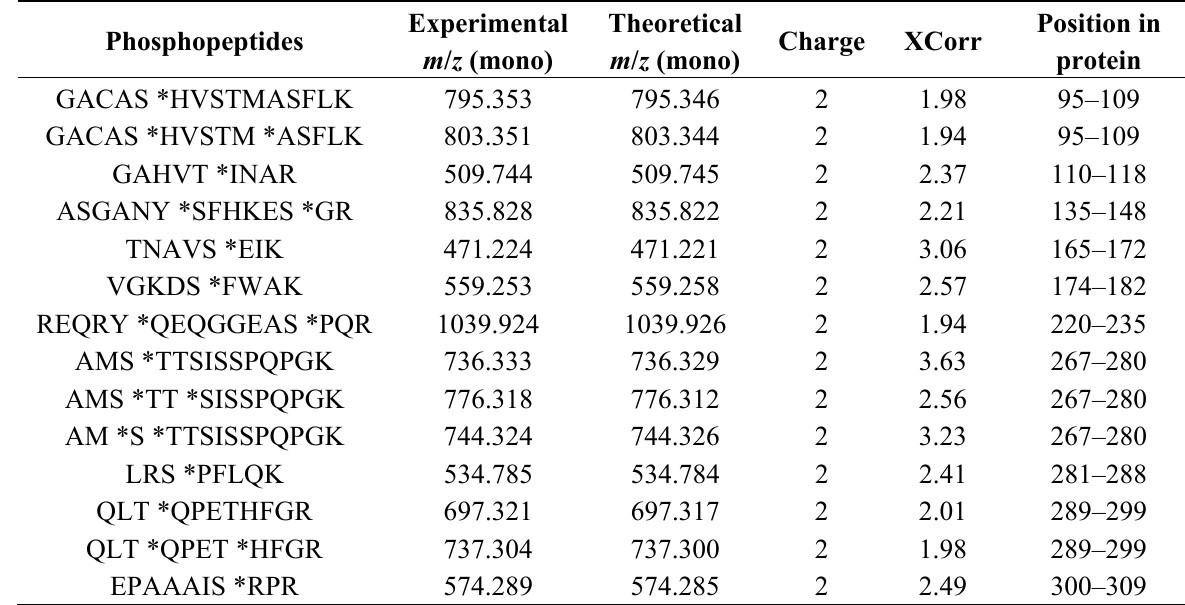
Table 1. Identification of phosphopeptides within HIP-55 protein over-expressed in HEK293